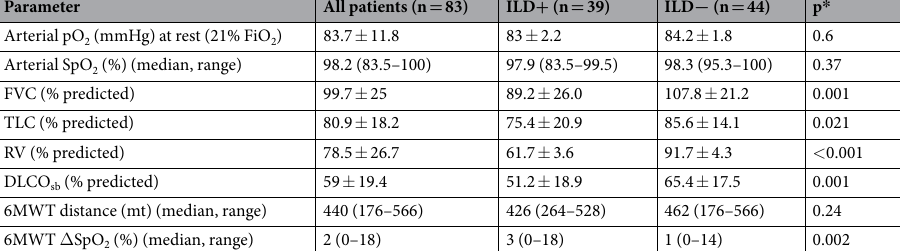
Table 2. Lung function assessment in the SSc patients at baseline. Data are expressed as mean ± standard deviation, except where otherwise indicated. SSc = systemic sclerosis; ILD = interstitial lung disease; pO 2 = oxygen partial pressure; FiO 2 = fraction of inhaled oxygen; SpO 2 = oxygen saturation; FVC = forced vital capacity; TLC = total lung capacity; RV = residual volume; DLCO sb = single breath diffusion lung capacity for carbon monoxide; 6MWT = six-minute walk test; mt = meters. * p is ILD + versus ILD − .